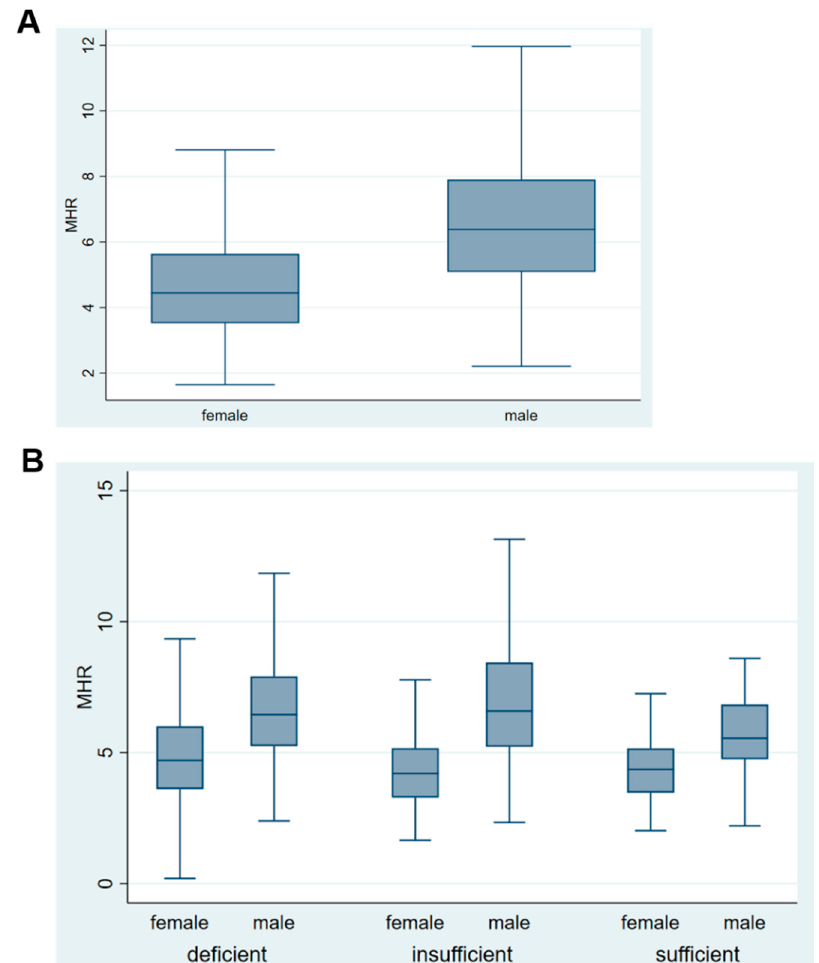
Figure 2. Comparison of MHR based on serum 25(OH)D concentrations in healthy young adults in Qatar. Serum 25(OH)D concenrtations were defined as deficiency (<12 ng/mL), insufficiency (12-<20 ng/mL), and sufficiency ( ≥ 20 ng/mL). ( A ): Boxplots of MHR in women compared to men ( p < 0.001 for t -statistic). ( B ): Boxplots of MHR for men and women within vitamin D deficient ( p < 0.004 for independent, 2-tailed t -statistic), vitamin D insufficient ( p < 0.58 for independent, 2- tailed t -statistic), vitamin D sufficient ( p < 0.21 for independent, 2-tailed t -statistic) categories. To convert ng/mL to nmol/L, multiply with 2.496. Abbreviations: 25(OH)D, 25-hydroxyvitamin D; MHR, monocyte percentage to HDL cholesteorl ratio; VitD, vitamin